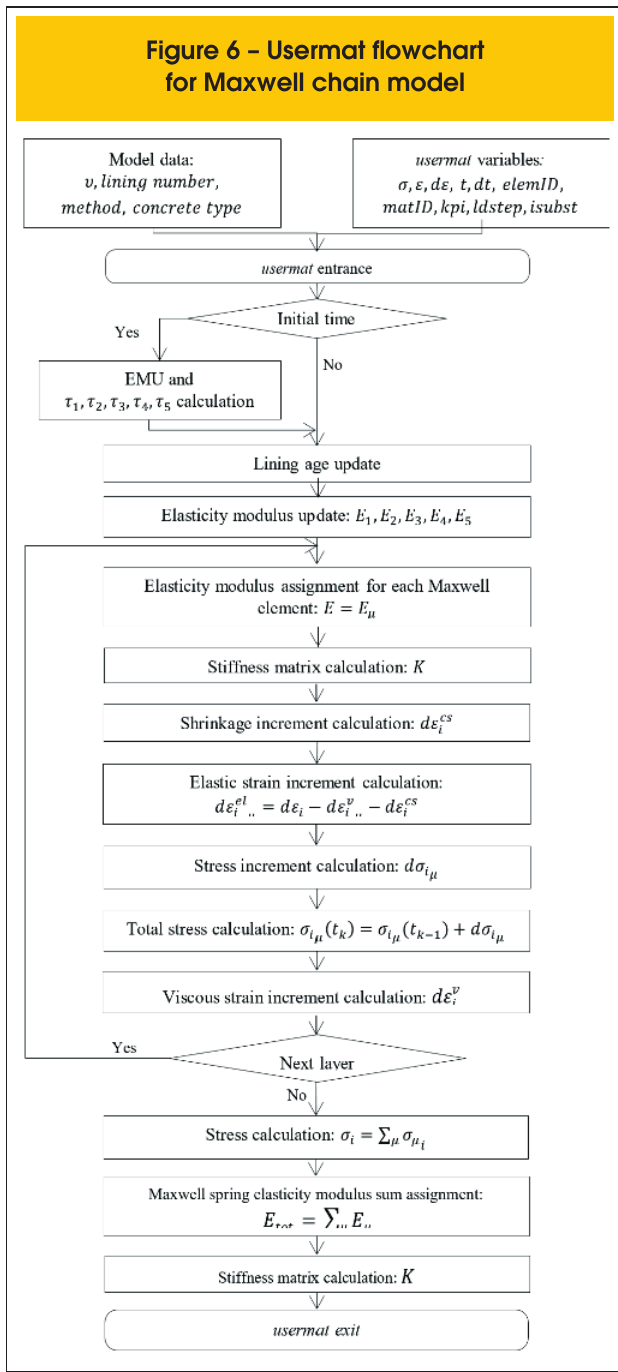
Figure 6 – Usermat flowchart for Maxwell chain